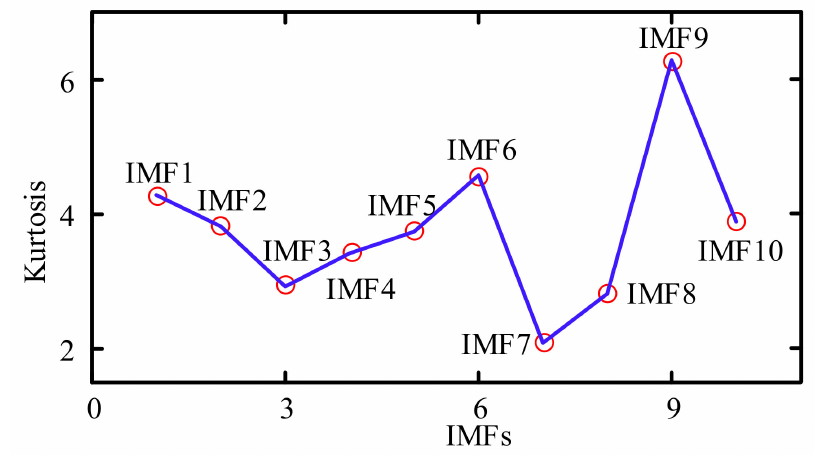
Figure 6. Kurtosis diagram of IMF components of time series signals (EMD).